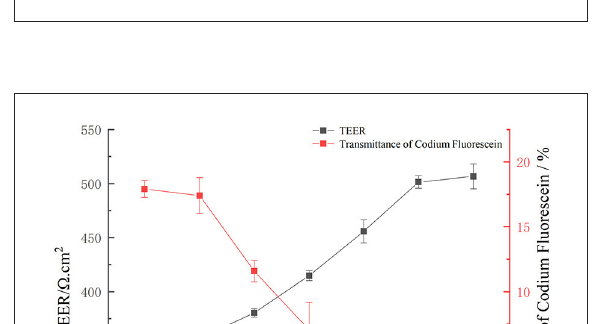
FIGURE2 (A) The morphological observation of Caco-2 cells by scanning electron microscope; (B–D) is the morphological changes of Caco-2 cells in different culture time.